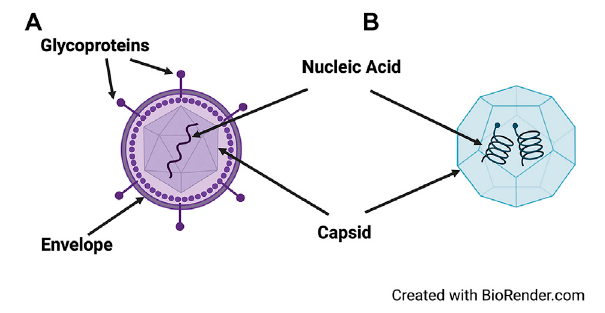
FIGURE 1 | Structure of a generic enveloped and non-enveloped virus. Viruses may be enveloped, containing an outermost layer of glycoproteins surrounding the capsid (A) , or non-enveloped (B) . They carry necessary geneticinformationontheirnucleicacid(DNAorRNA)thatisenclosed in a